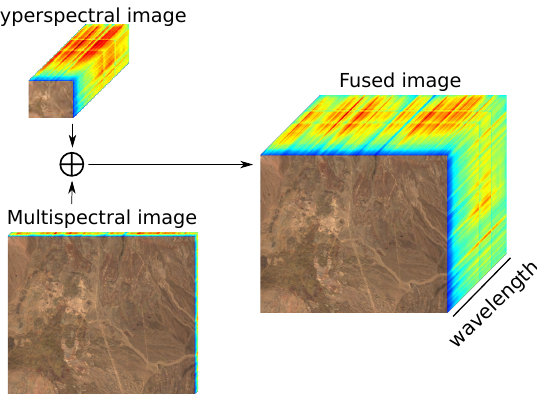
Figure 1. Hyperspectral images have high spectral resolution but low geometric resolution, whereas the opposite is true for multi- spectral images. In this paper, we aim at fusing the two types of